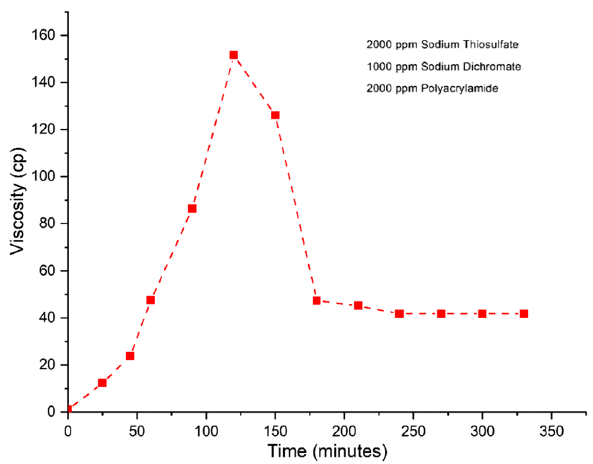
Fig. 4 Yield strength at different concentrations of Sodium thiosulfate under ambient conditions (24 °C and 14.7